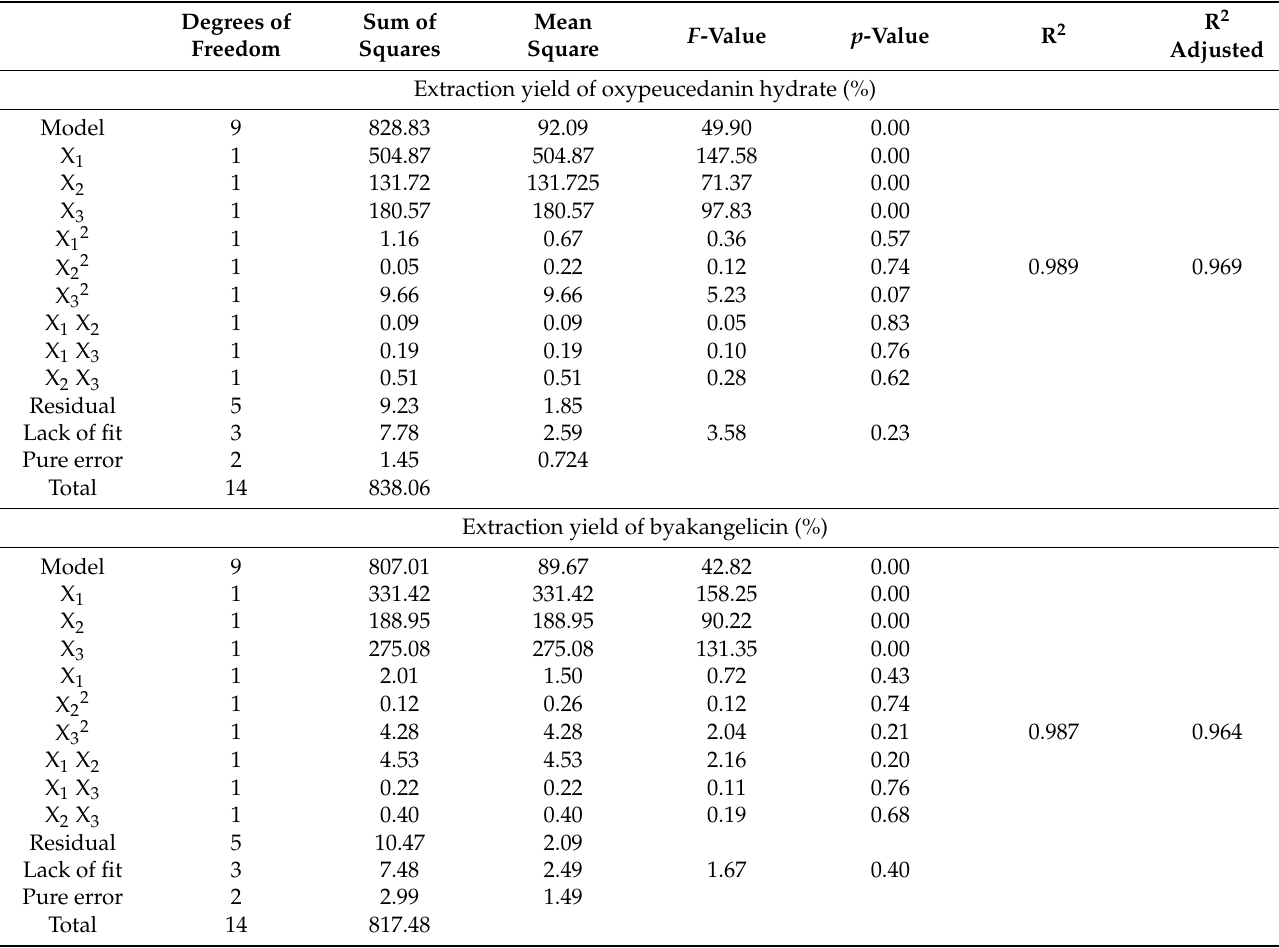
Table 3. Variance analysis for the quadratic response surface regression